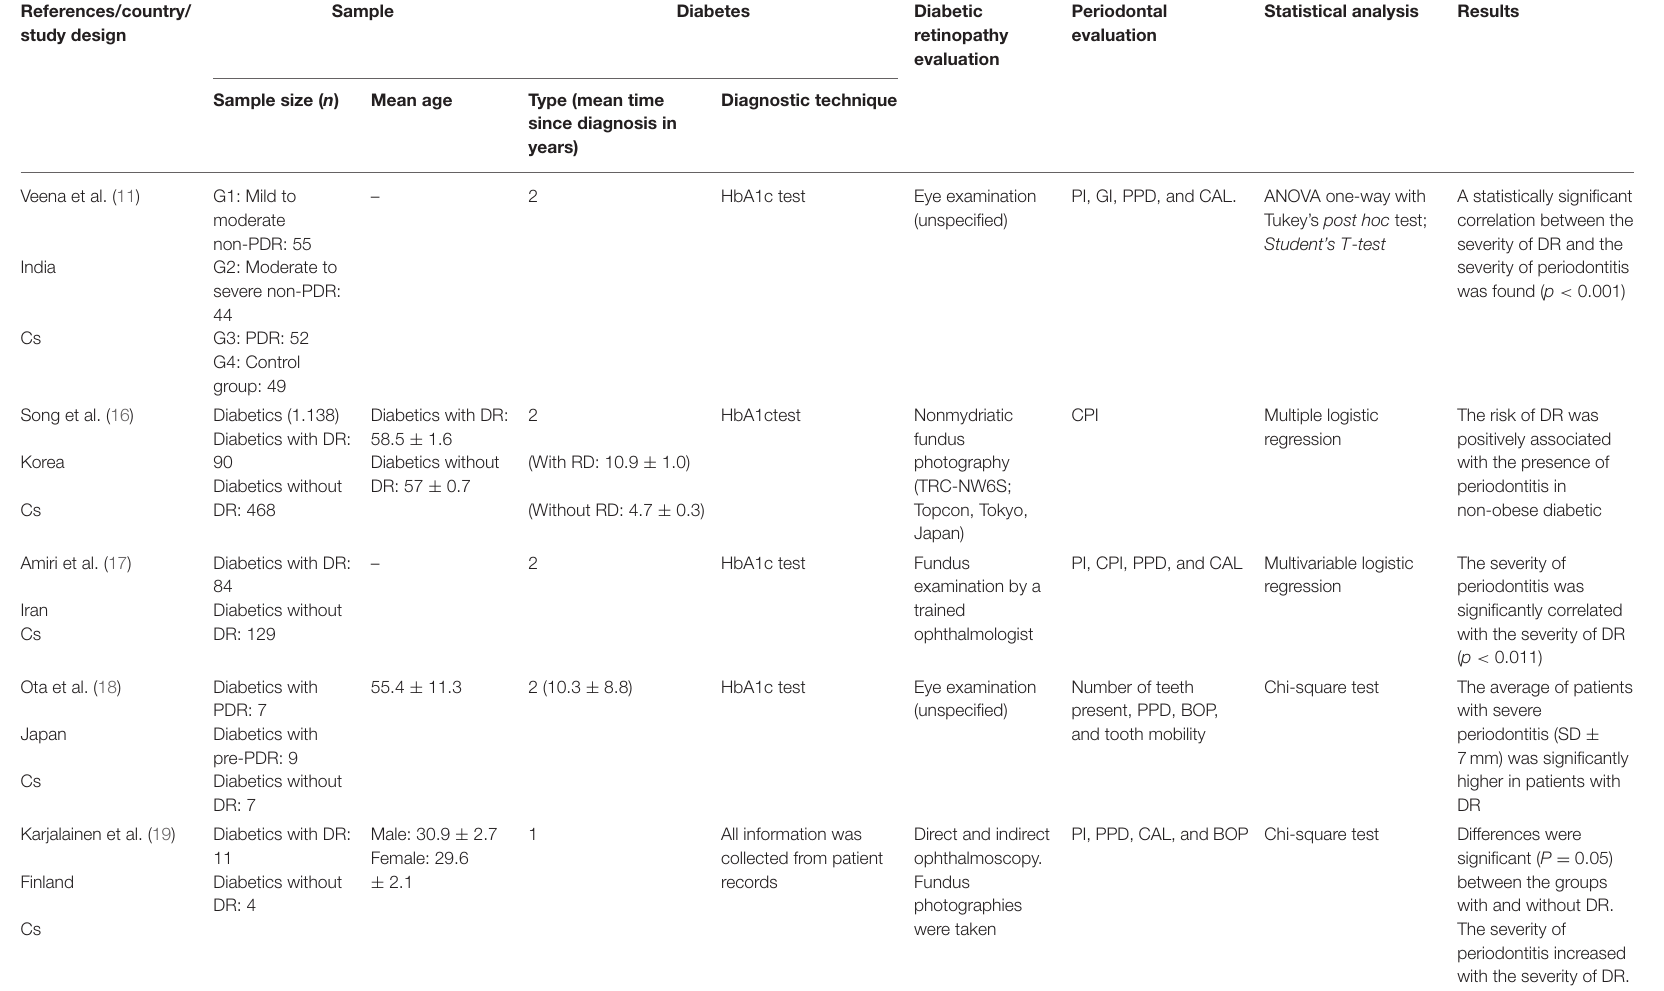
TABLE 1 | Summary of characteristics of the included